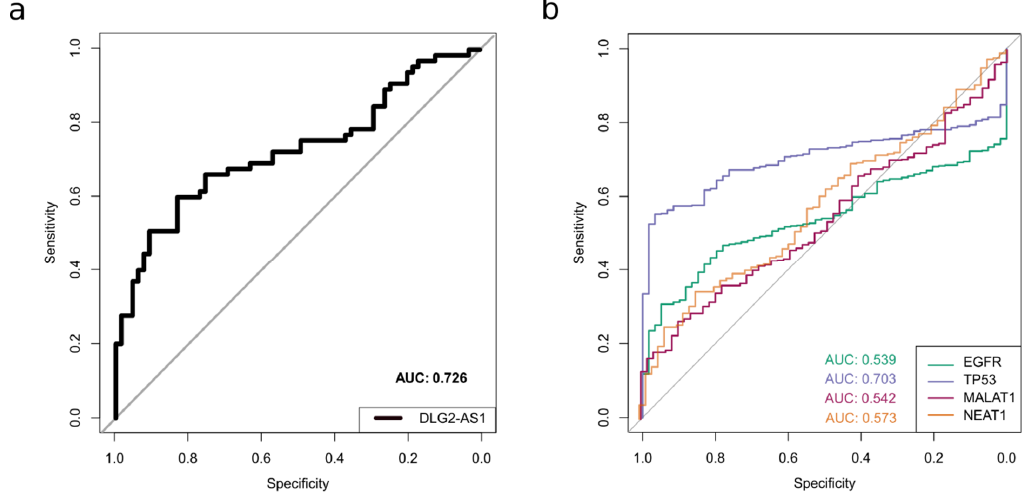
Figure 2. DLG2-AS1 shows potential as a lung adenocarcinoma (LUAD) biomarker: ( a ) receiver operating characteristic (ROC) curve and area under curve (AUC) value of DLG2-AS1 expression in our cohort of LUAD patients; and ( b ) ROC curves and AUC values of other LUAD biomarkers (EGFR, TP53, MALAT-1, and NEAT1), obtained from TCGA data.